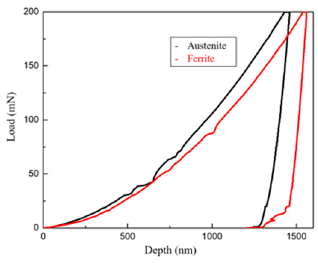
Figure 5. Microhardness of austenite and ferrite phases in LDX-2101 steel.